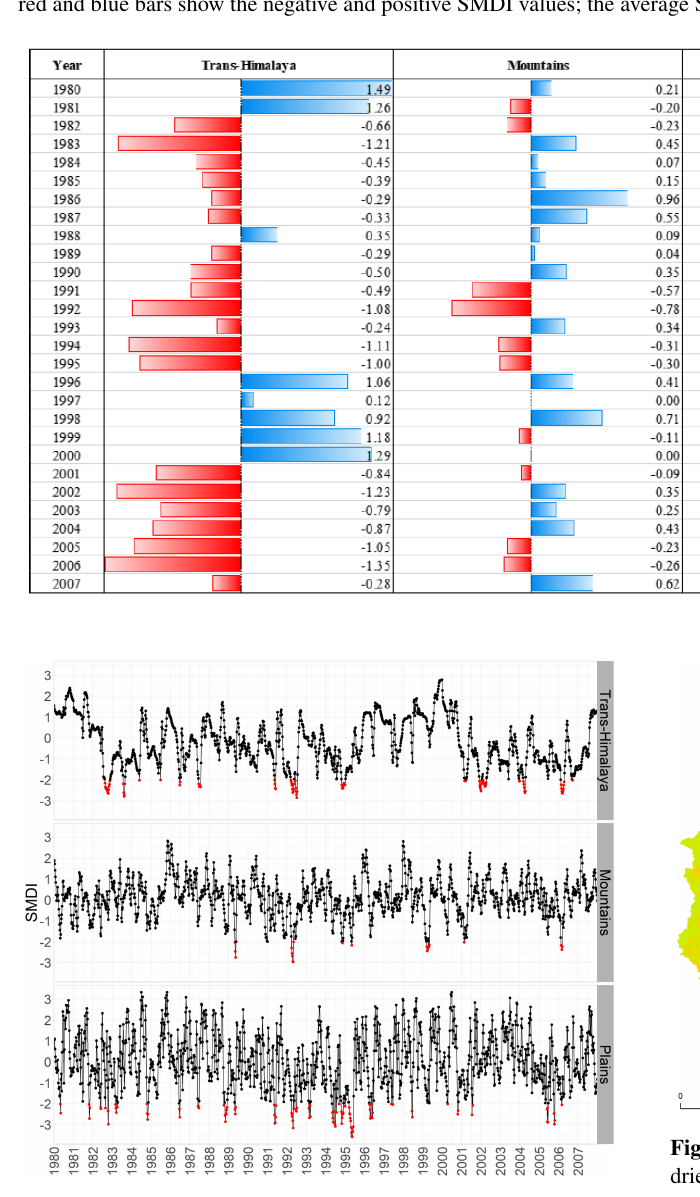
Figure 7. Average weekly SMDI values for three regions of the KRB. Note: red dots show SMDI values below − 2.